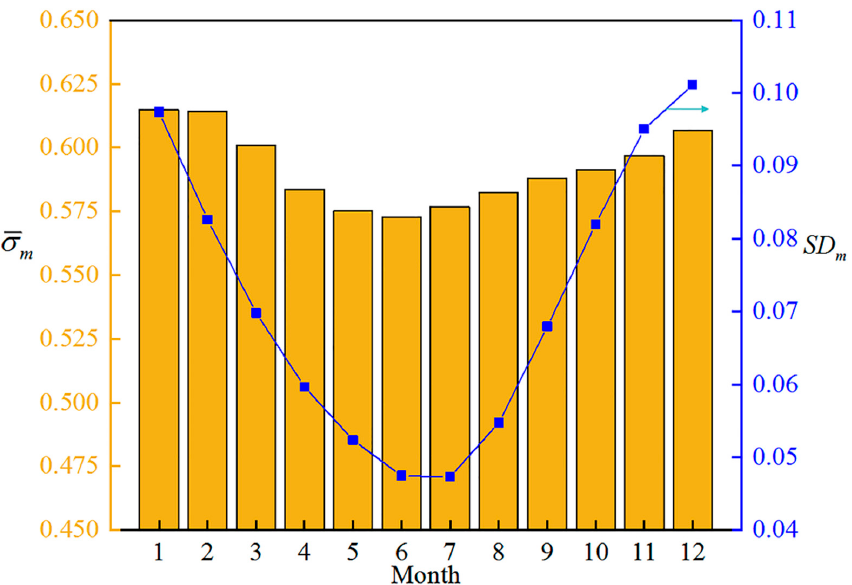
Figure 13. Variation of the monthly average effective tracking factor σ m and SD m of an SDC system. Table 3. Extreme values of effective tracking factors and corresponding dates for different tangential angles in a whole year operation cycle when the radial angle of azimuth axis is 0.1°.